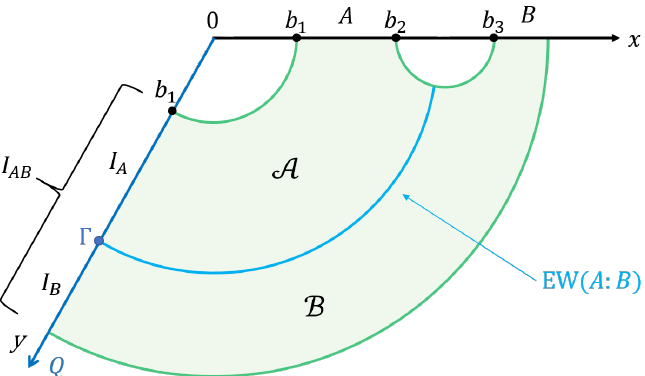
Figure 4. An illustration of the island formula for reflected entropy. The entanglement wedge of A ∪ B is the green shaded region, where there exists a minimal entanglement wedge cross section EW ( A : B ) that splits the bulk into A and B , which corresponds to the boundary intervals A and B respectively. The intersection of EW ( A : B ) and Q is denoted by Γ , which is the island cross section from boundary point of